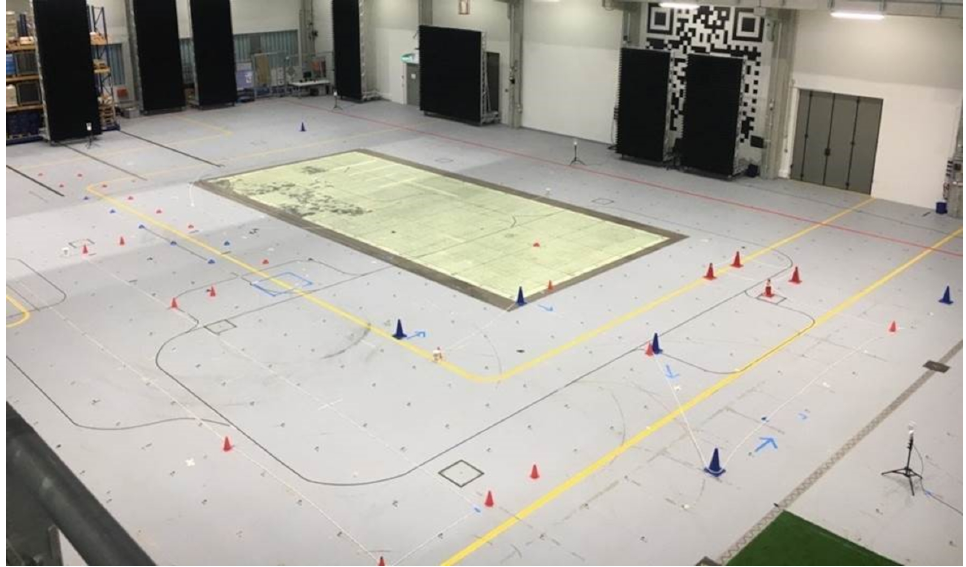
Figure 3. Test setup at the Fraunhofer L.I.N.K test hall in